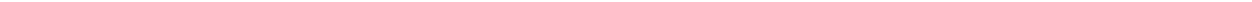
Fig. 2 A proteogenomics work fl ow to discover, curate, and validate novel and SAAV peptides. The pipeline consists of three major stages: discovery, curation, and validation. The discovery stage is performed with MS-GF + using two database strategies. Type 1 search was performed against a single database consisting of known peptides concatenated with variant peptides. Type 2 search is enabled by HiRIEF peptide fractionation and was performed against pI- restricted databases of tryptic peptides generated from a six-frame translation (6FT) of the human genome. The discovery stage outputs 1% class-speci fi c FDR for novel and SAAV peptides. In the curation stage, candidate SAAV peptides are curated by SpectrumAI. The novelty of candidate novel peptides from the discovery stage is ensured by BLASTP analysis against known protein databases including Uniprot reference proteome (with isoforms), Ensembl human protein database v83, RefSeq and Gencode v24, and the subset of novel peptides with single amino acid substitution are also curated by SpectrumAI. In the validation stage, quality control plots such as delta pI, precursor mass error, and search engine score distribution are made. In addition, curated novel peptides are evaluated for orthogonal data support in, e.g., RNA-seq data, ribosome pro fi ling and CAGE data, conservation and coding potential